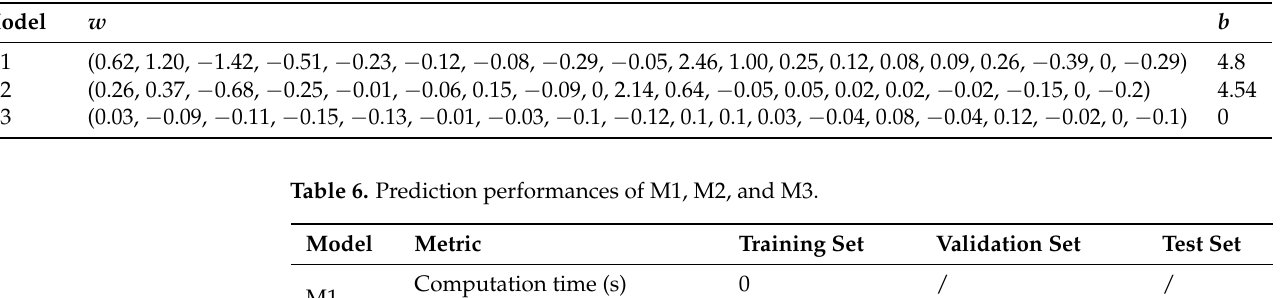
Table 5. Coefficients value of w and b in M1, M2, and M3.